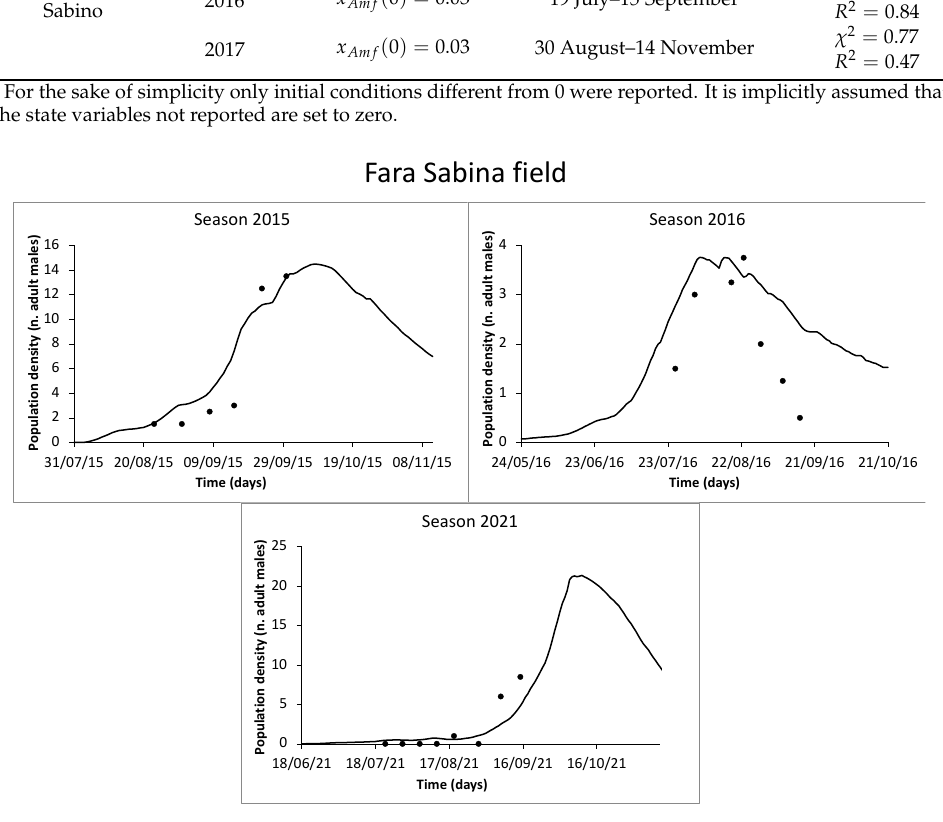
Figure 4. Comparison between simulations and experimental data collected in the Fara Sabina field. Dots express the field population samplings (mean value provided by three traps), while continuous lines are the simulations carried out through the model (3). Additional information about the model validation is listed in Table 4.